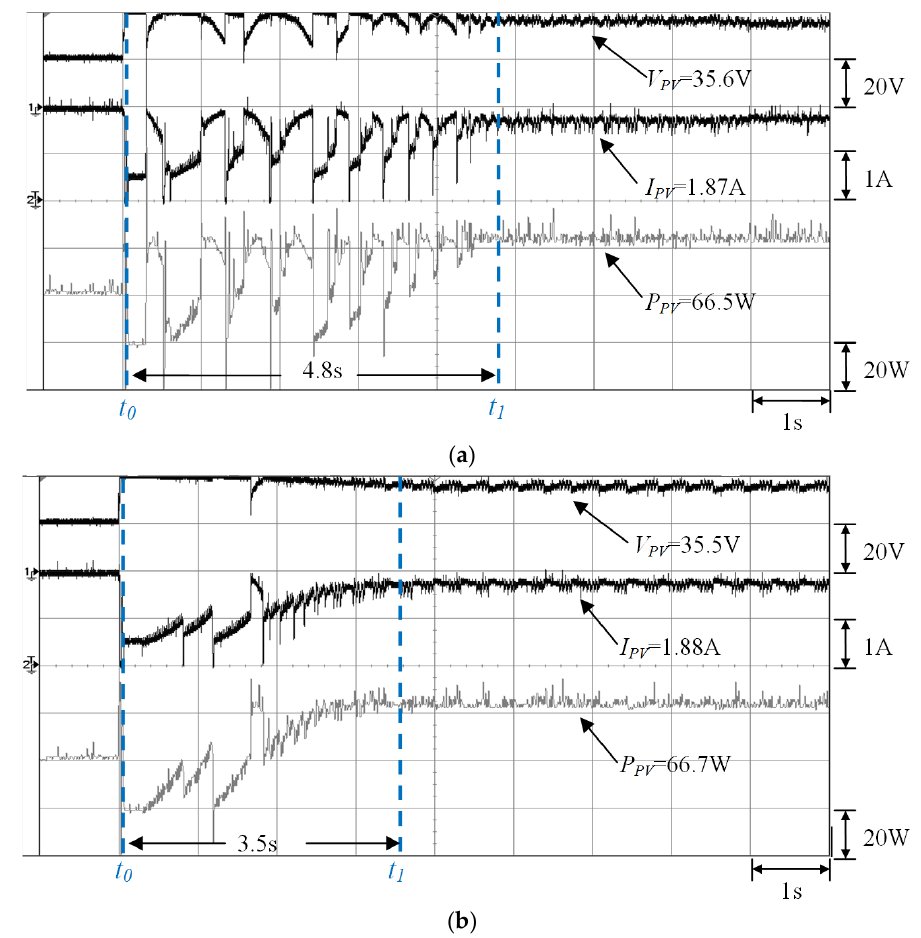
Figure 16. Results of the two-serial and two-parallel module array [(0% and 30% shading)//(0% and 50% shading)] measured by using ( a ) conventional TLBO ( P mp = 66.5 W) and ( b ) the proposed I-TLBO ( P mp = 66.7 W).